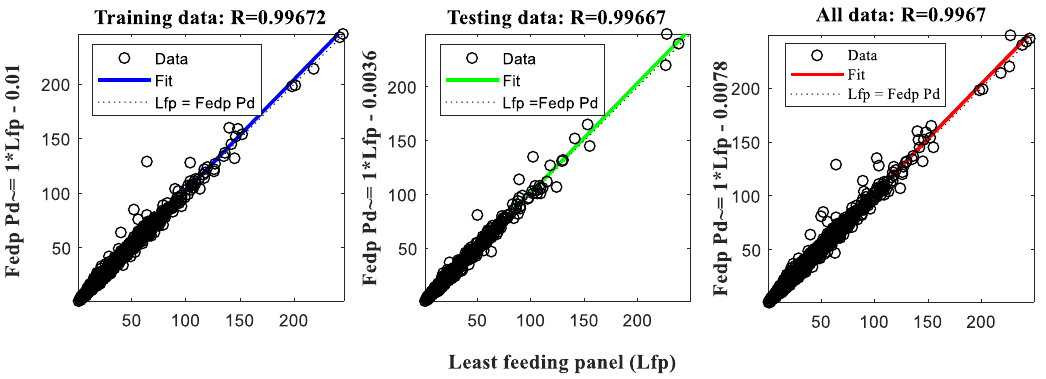
Figure 7. Regression of predicted feeding panel versus least feeding panel.